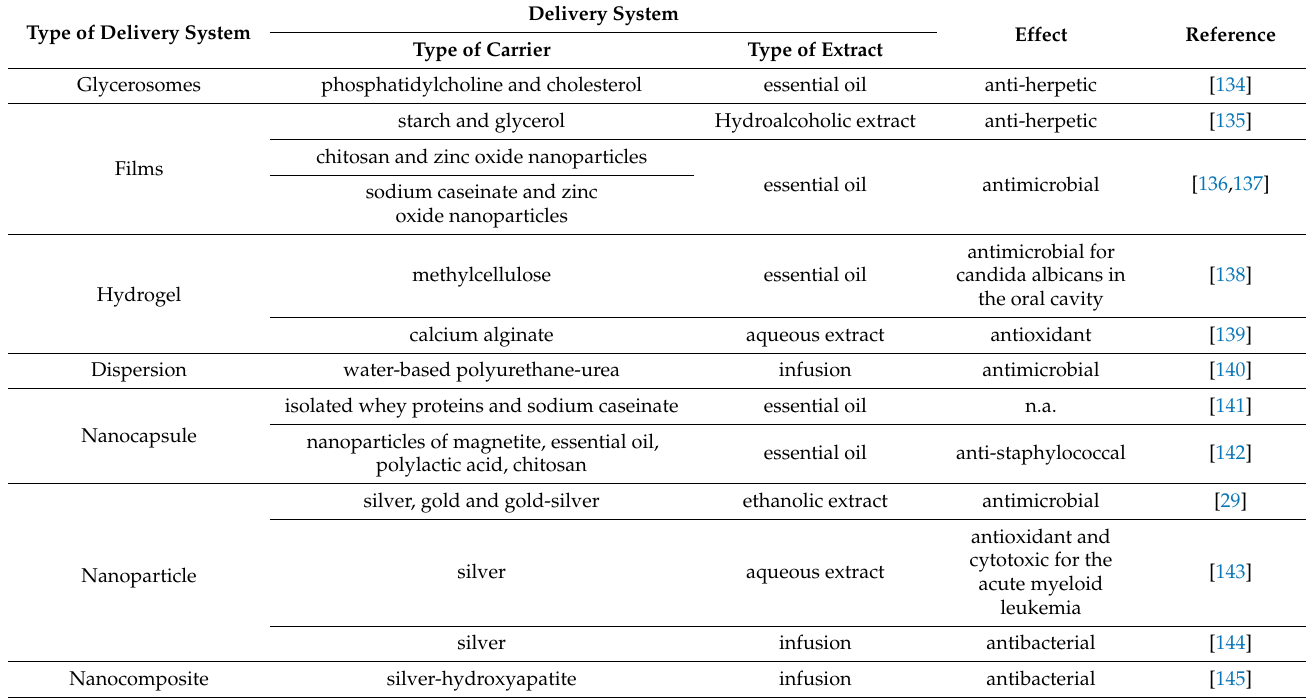
Table 7. Controlled release systems with Melissa officinalis